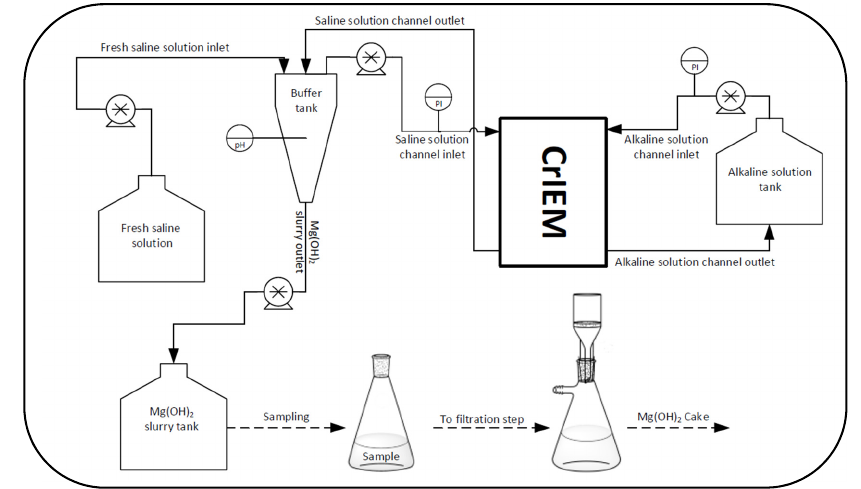
Figure 3. Sketch of the experimental set-up.